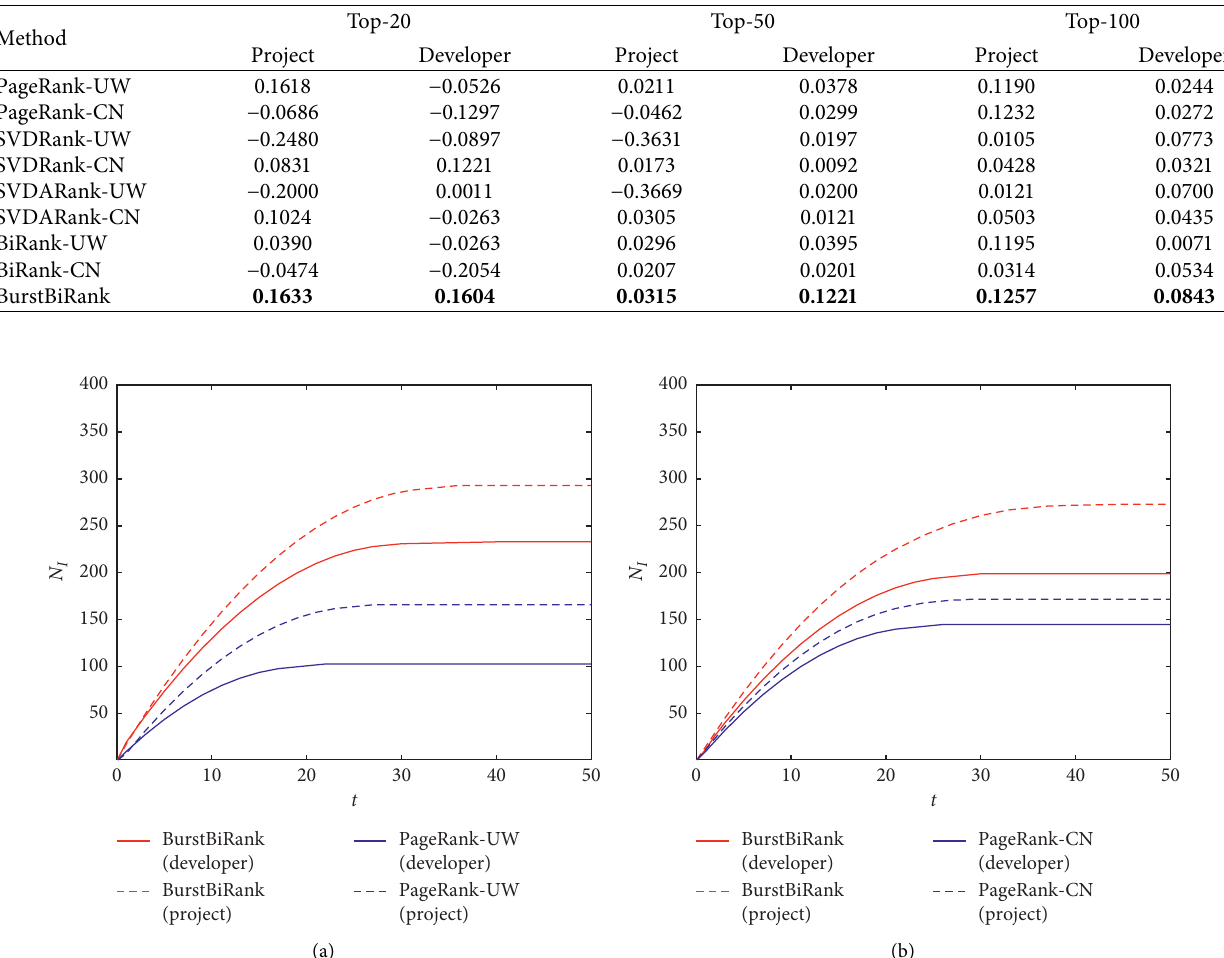
Figure 4: Performance comparison between BurstBiRank and PageRank. (a) BurstBiRank vs. PageRank-UW. (b) BurstBiRank vs. PageRank-CN.